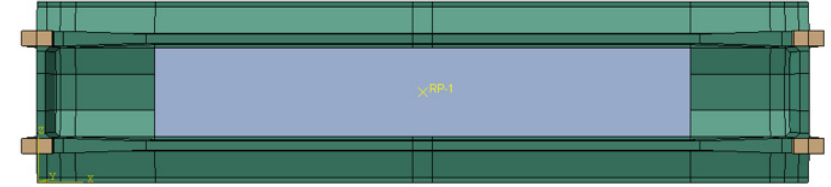
Figure 14. The model of the polyurethane concrete reinforcement layer.